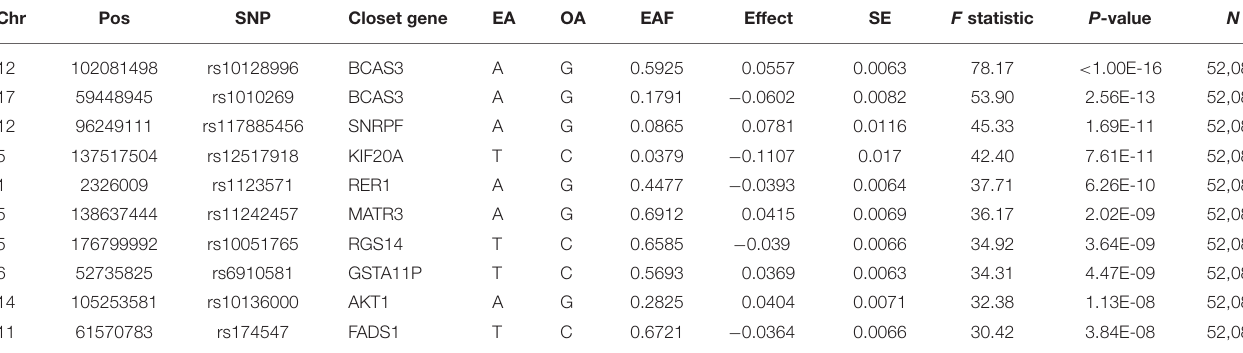
TABLE 1 | Characteristics of SNPs for plasma Vitamin C from the GWAS meta-analysis.